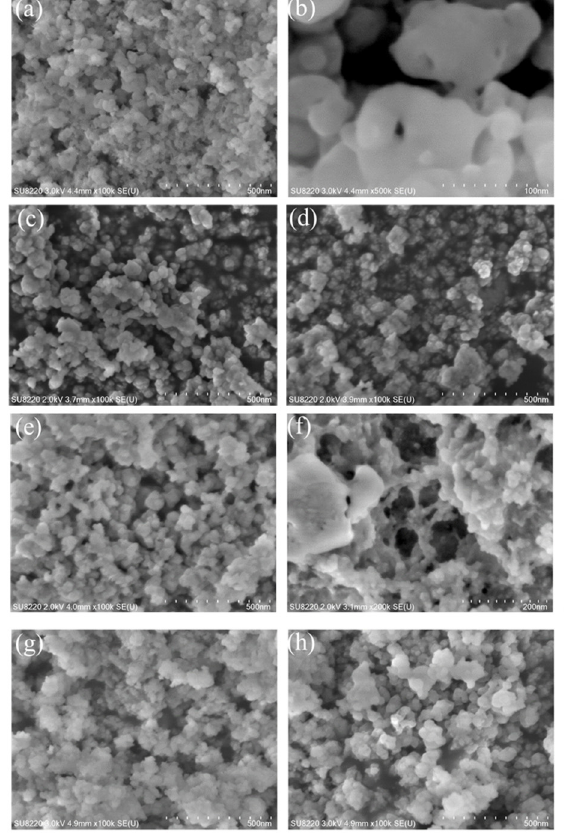
Figure 19. FE ‐ SEM images ( a , b ) C ‐ A ‐ S ‐ H; ( c ) C ‐ A ‐ S ‐ H/KH550; ( d ) C ‐ A ‐ S ‐ H/KH560 ( e , f ) C ‐ A ‐ S ‐ H/KH570; ( g ) C ‐ A ‐ S ‐ H/PVA; ( h ) C ‐ A ‐ S ‐ H/PAA ‐